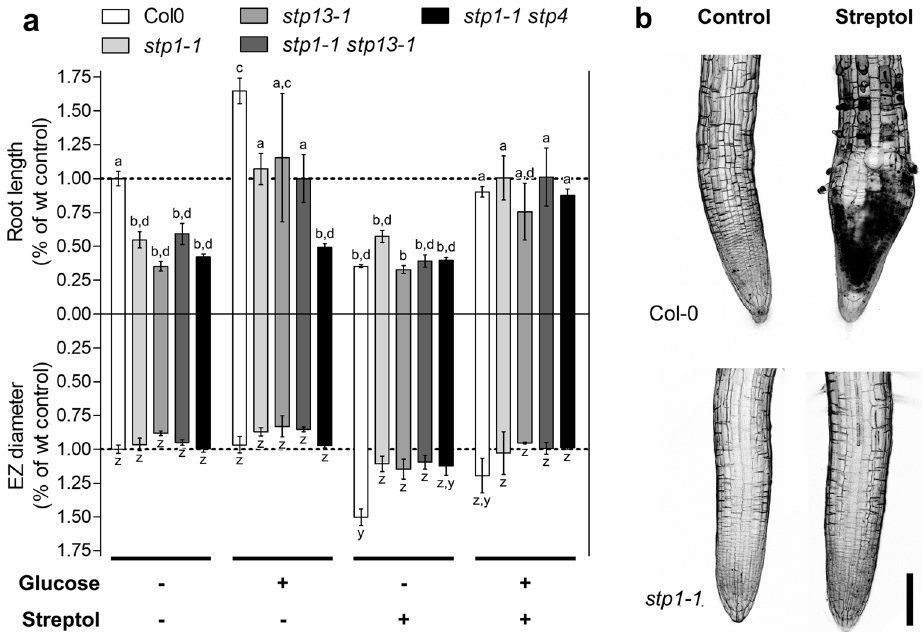
Figure 3. Streptol is transported by STP hexose symporters. ( a ) Root length and elongation zone diameter of wildtype and mutant seedlings grown in the presence or absence of 5 µM streptol and 2.5 mM d-glucose; values are relative to wildtype water controls. Significant differences between samples were analysed in a one-way ANOVA with Tukey’s post-hoc test; significantly different means ( p -value < 0.05) are marked with different letters. Data represent the mean values of at least three biological replicates; standard errors are indicated. ( b ) Representative micrographs of wildtype and stp1 mutants root apex phenotype after 5 days of growth in 5 µM streptol. Bar = 100